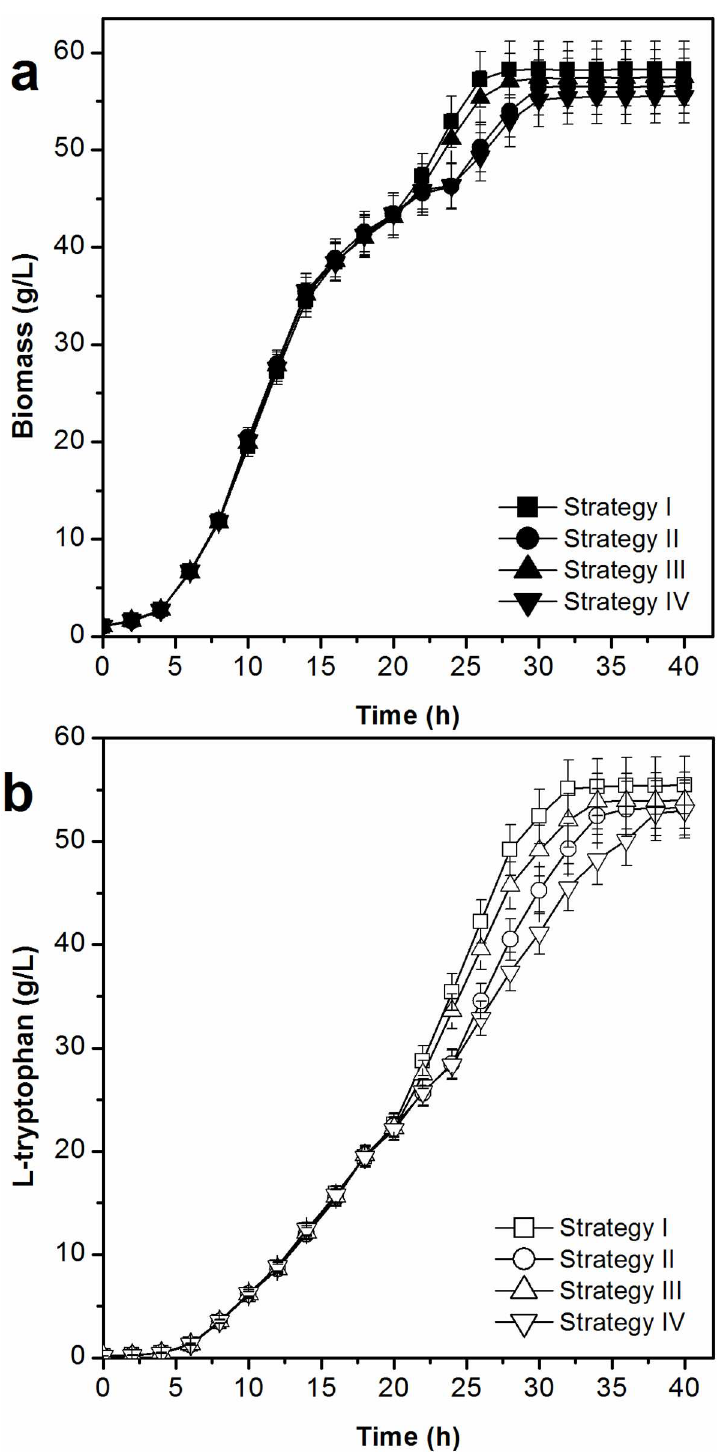
Fig 6. Effect of a cell recyclestrategy on biomass and production of L-tryptophan in L-tryptophan fermentation by TRTHBPA ( P < 0.05).